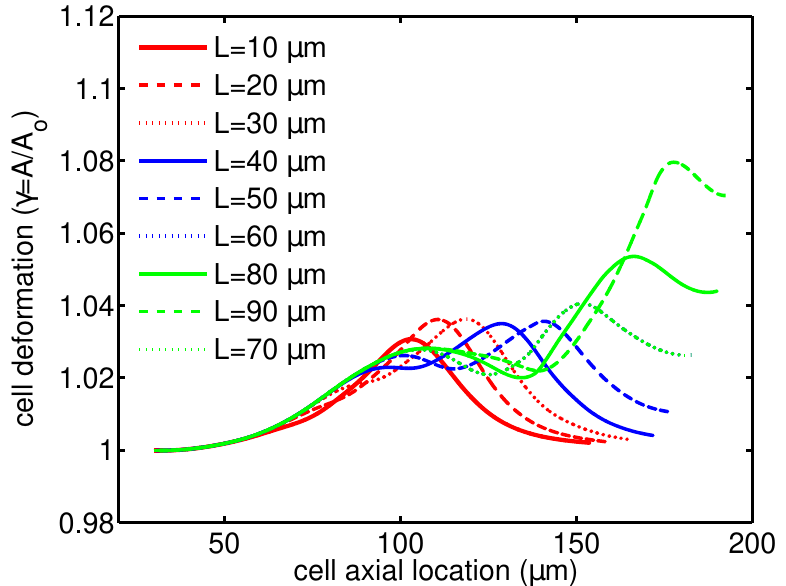
Figure 10. Deformation of an HL60 cell passing through microchannels with different constriction lengths at λ = 0.1 s, β = 0.5, Ca = 0.00076 and Re =